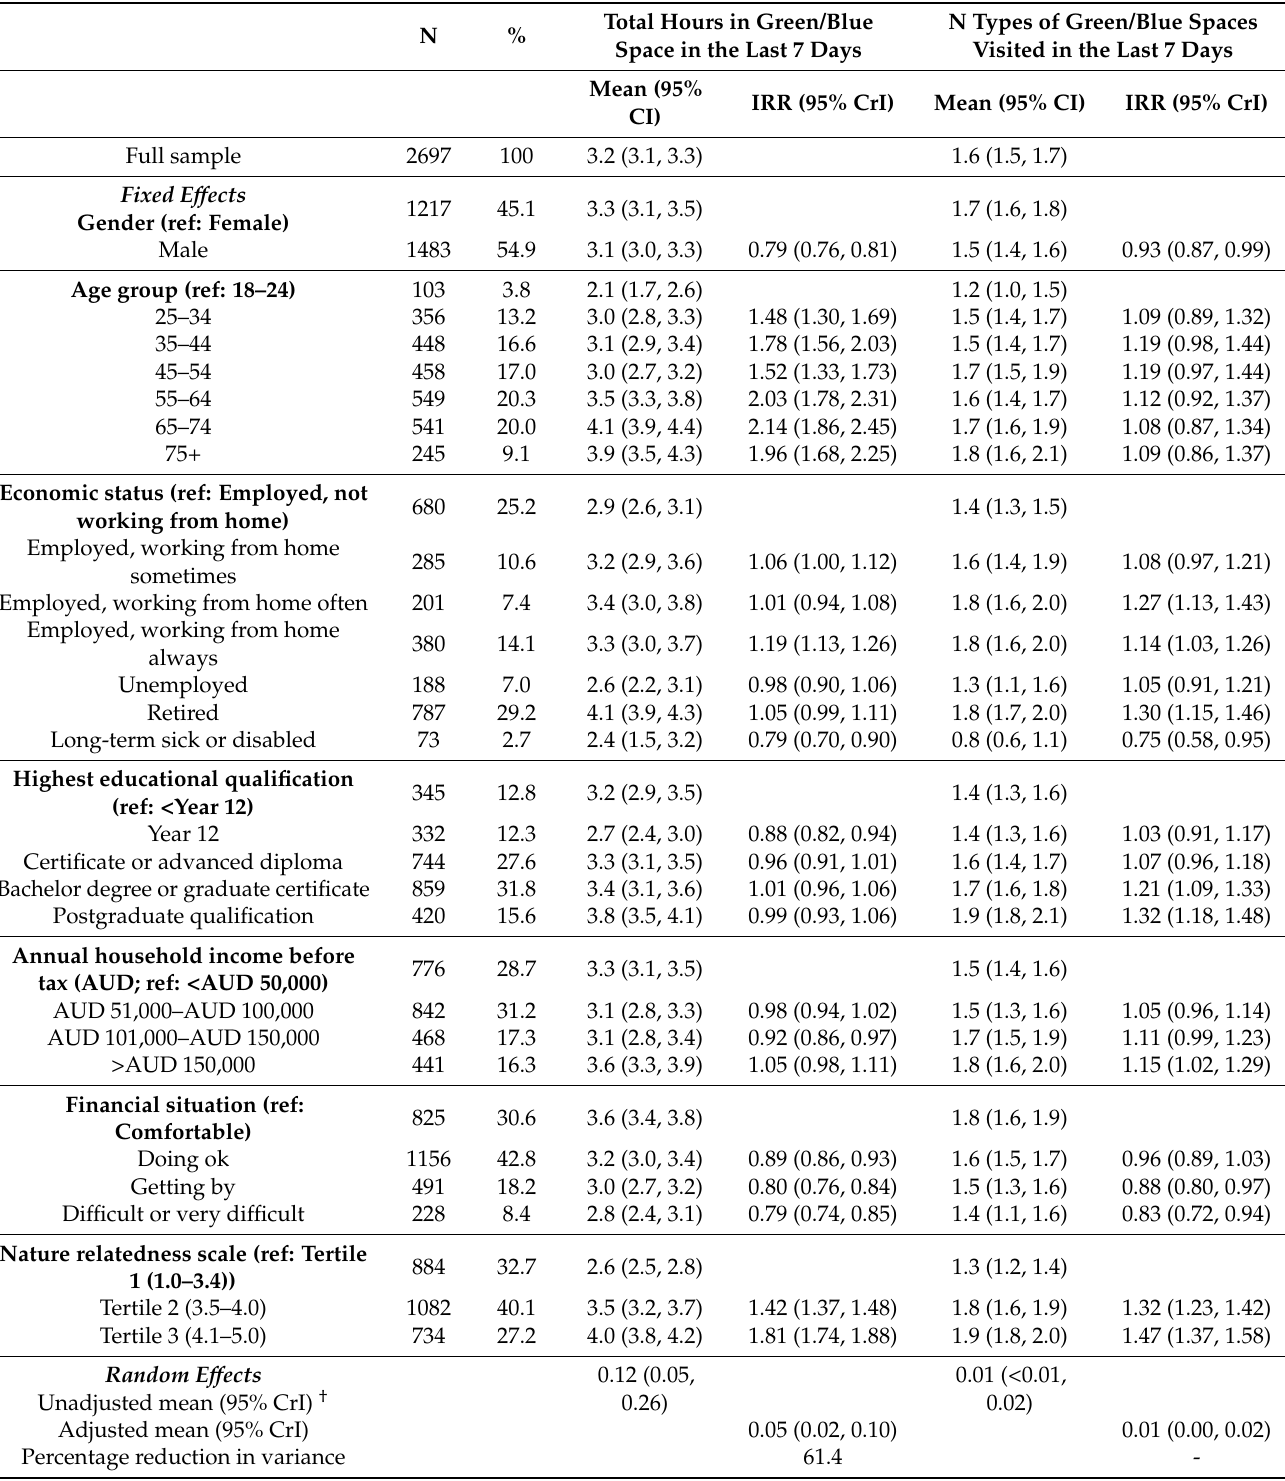
Table 3. Associations with visits to preferred green or blue spaces during the COVID-19 pandemic. Total Hours in Green/Blue N Types of Green/Blue Spaces N % Space in the Last 7 Days Visited in the Last 7